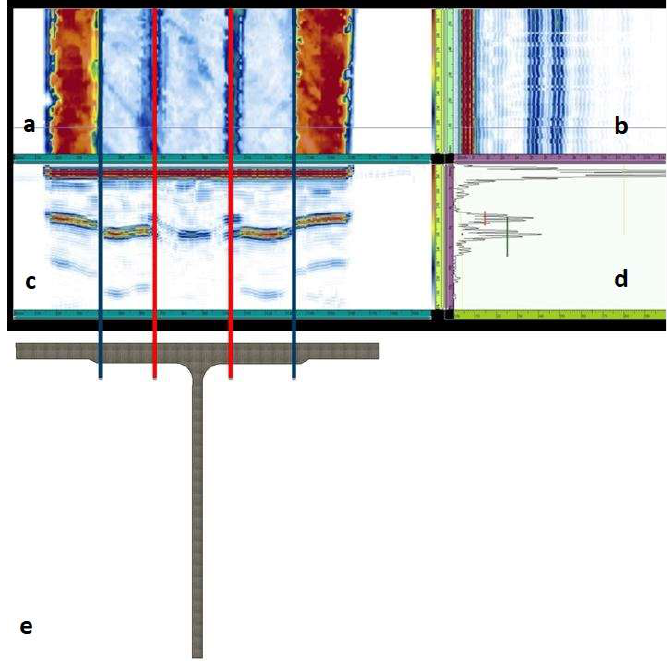
Figure 8. Correspondence between ultrasonic images and specimen typical geometry: ( a ) C-scan; ( b ) D-scan; ( c ) B-scan; ( d ) A-scan; and ( e ) specimen geometry. Red lines localize the defects position and blue lines correspond to the thickness variation at the skin-cap interface.